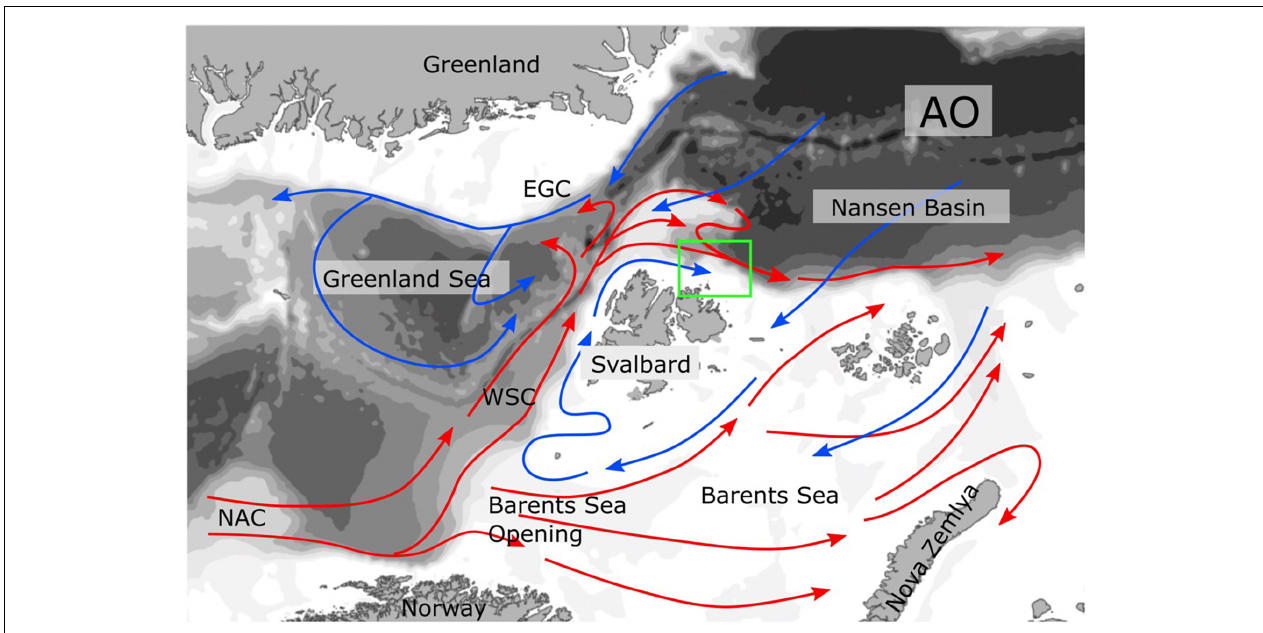
FIGURE 1 | Currents in the Northern Norway, Fram Strait, Barents Sea, and Arctic Ocean (AO) region. The warm currents dominated by Atlantic Water are marked in read, for example the North Atlantic Current (NAC), and West Spitsbergen Current (WSC). The cold Arctic Water currents are in blue, for example the East Greenland Current (EGC). In the Lofoten/Vesterålen region the NAC touches the North Norwegian shelf and forms a strong slope current.